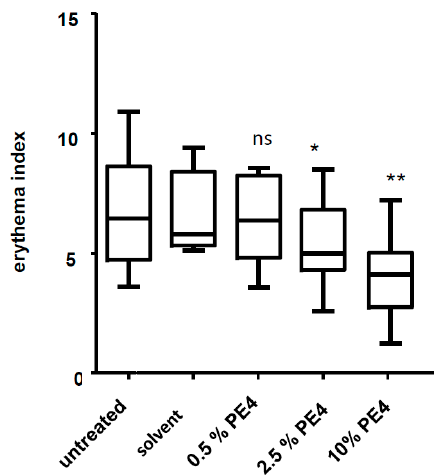
Figure 7. Inhibition of UVB-induced erythema in human skin in vivo . Test areas on the back of 8 volunteers were irradiated with 1.5 minimal erythema doses (MED). Subsequently the test areas were occlusively treated for 48 h with the vehicle or the indicated concentrations of PE4. Data are expressed as mean ± SD and the statistical significance was determined compared to the solvent control (* p < 0.05; ** p < 0.01).